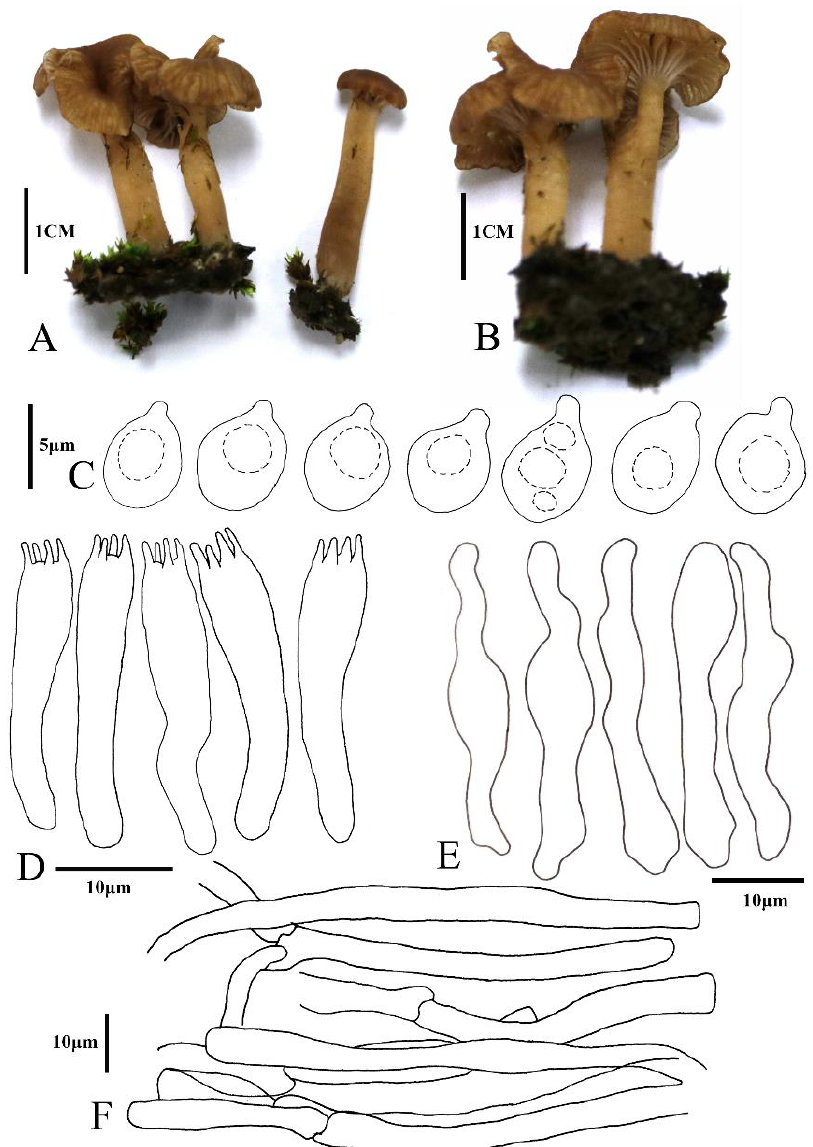
Figure 4. The basidiomes ’ habits and the anatomic structure of Omphalina licheniformis sp. nov (ZRL 20220005, HMAS 281952, isotype). ( A , B ) Basidiomes. ( C ) Basidiospores. ( D ) Basidia. ( E ) Cheilocys- tidia. ( F ) Pileipellis hyphae.